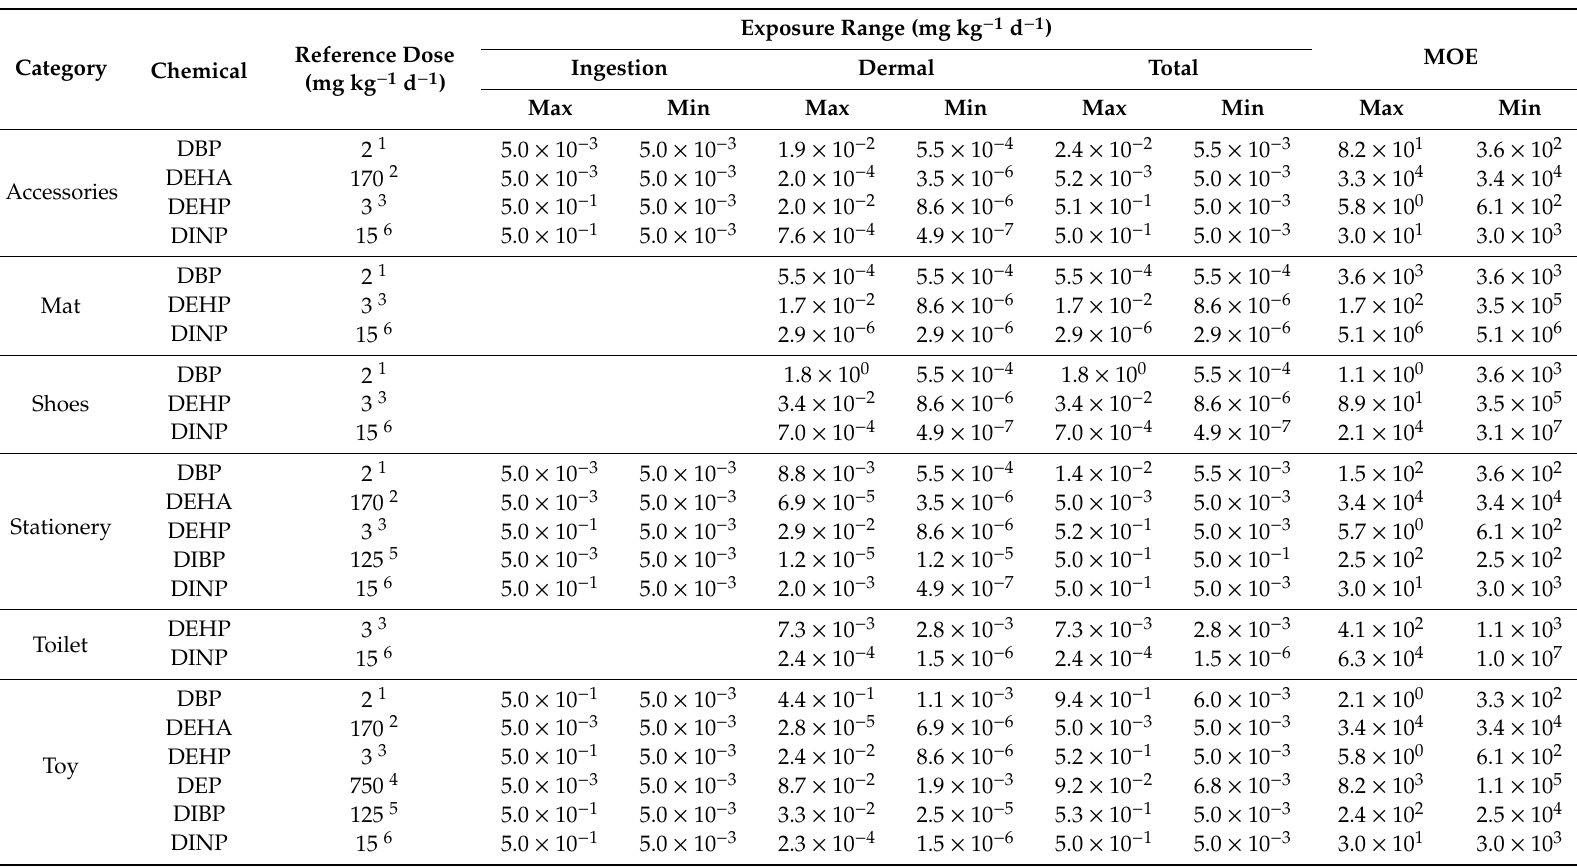
Table 3. Estimated the maximum and minimum exposure ranges and calculated margin of exposure (MOE) from reference